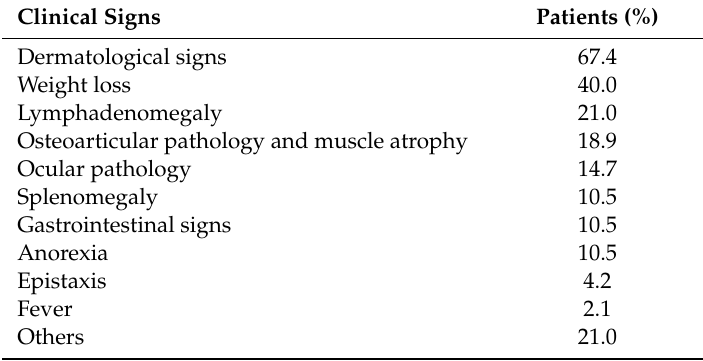
Table 2. Clinical signs compatible with canine leishmaniosis at the time of diagnosis, n = 95.